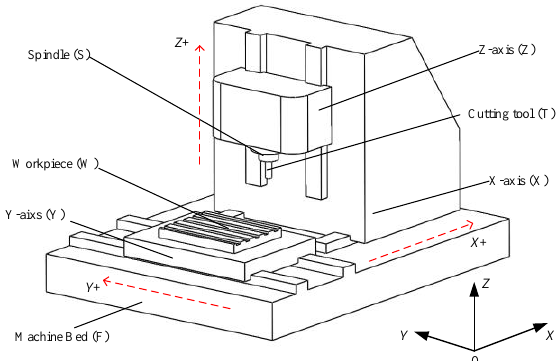
Figure 1. Structure of WYFXZT type three-axis machine tool.